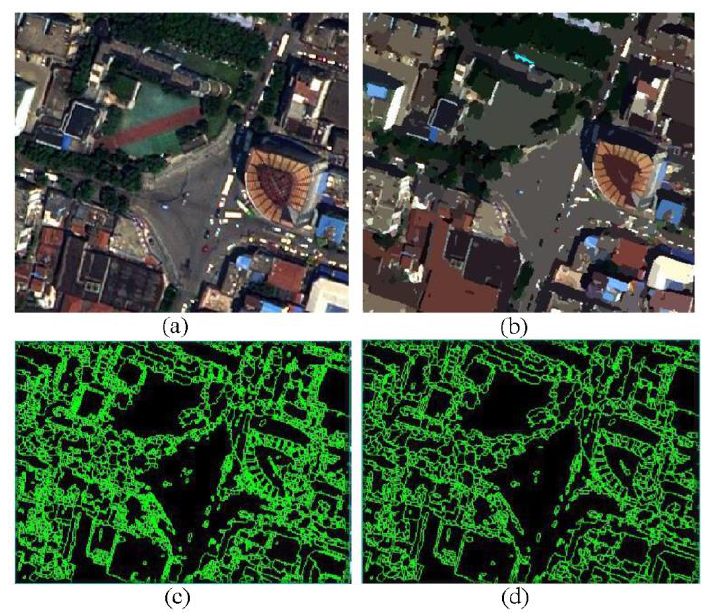
Figure 4. ( a ) the top left picture represents WorldView image before segmentation; ( b ) the top right picture represents WorldView image after segmentation; ( c ) the bottom left picture represents extraction results before image segmentation; ( d ) the bottom right picture represents extraction results after image